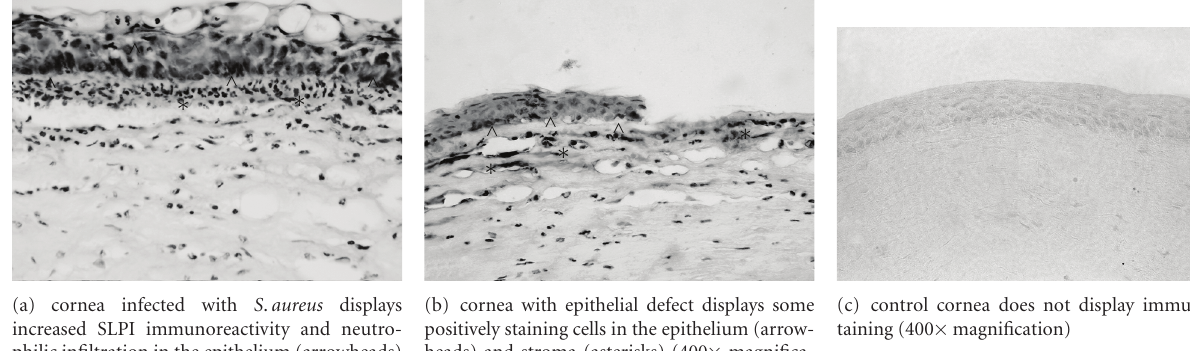
Figure 1: Immunolocalization of SLPI at 48 hours in corneas with S . aureus keratitis, epithelial defect, and control.